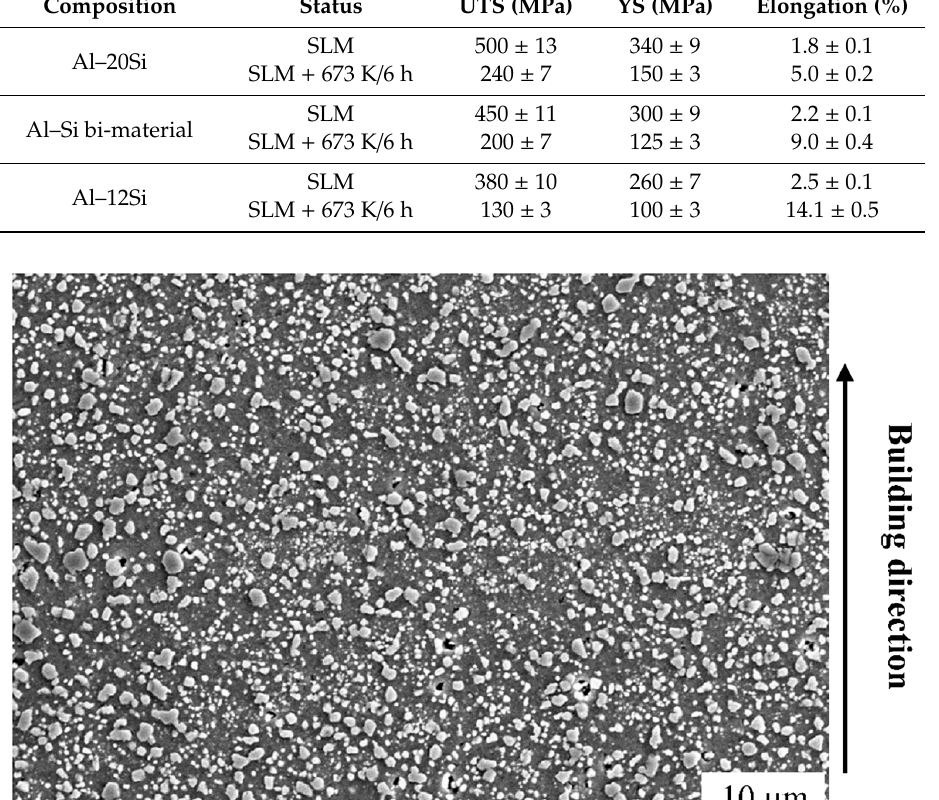
Table 1. Mechanical properties of Al–Si alloys and the Al–Si bi-material. UTS = ultimate tensile strength; YS = yield